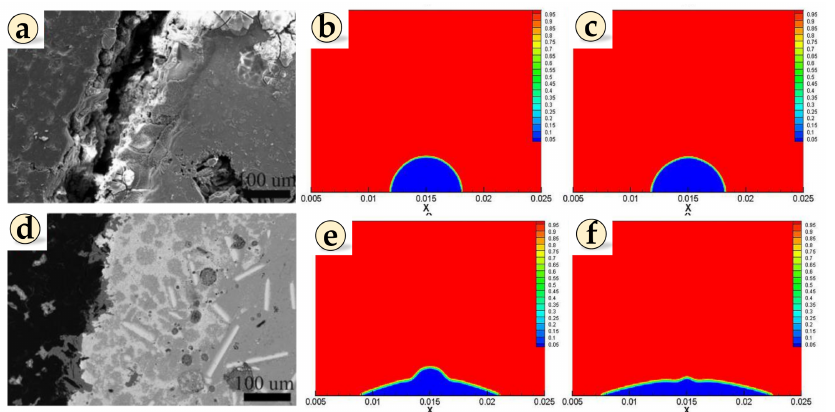
Figure 7. The wetting and spreading effect of ultrasonic irradiation in carbon/aluminum system. ( a ) the SEM of interface without ultrasonic at the time steps of ( b ) 900 and ( c ) 1300 steps. ( d ) the SEM of interfacial region with ultrasonic at the time steps of ( e ) 900 and ( f ) 1300 steps